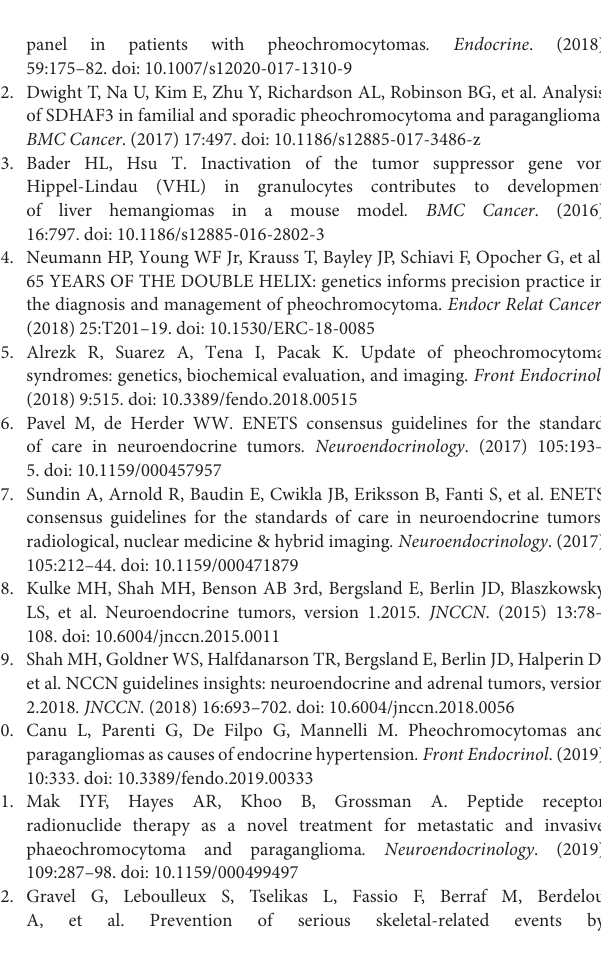
Figure S1 | Trend of NE markers in relation to neoplastic occurrence over the course of the clinical history. CgA, Chromogranin A ( < 90ng/mL); U catecholamines, urinary catecholamines ( < 100 mcg/24h); U metanephrines, urinary metanephrines ( < 354 mcg/24h); VMA, vanillylmandelic acid (urinary VMA spot test: positivity was expressed graphically as a value of 100). The endocrinological work-up in 2008 included serum assessment of noradrenaline and adrenaline, which were not expressed in the panel, while CgA, VMA and U metanephrines were reported. Figure S2 | Sequencing of the MAX gene. Sequences of MAX mutation in genomic DNA from a venous blood sample. (A) shows Sanger image of MAX mutation analysis; (B) shows the MAX mutation analyzed with the Integrative Genomics Viewer